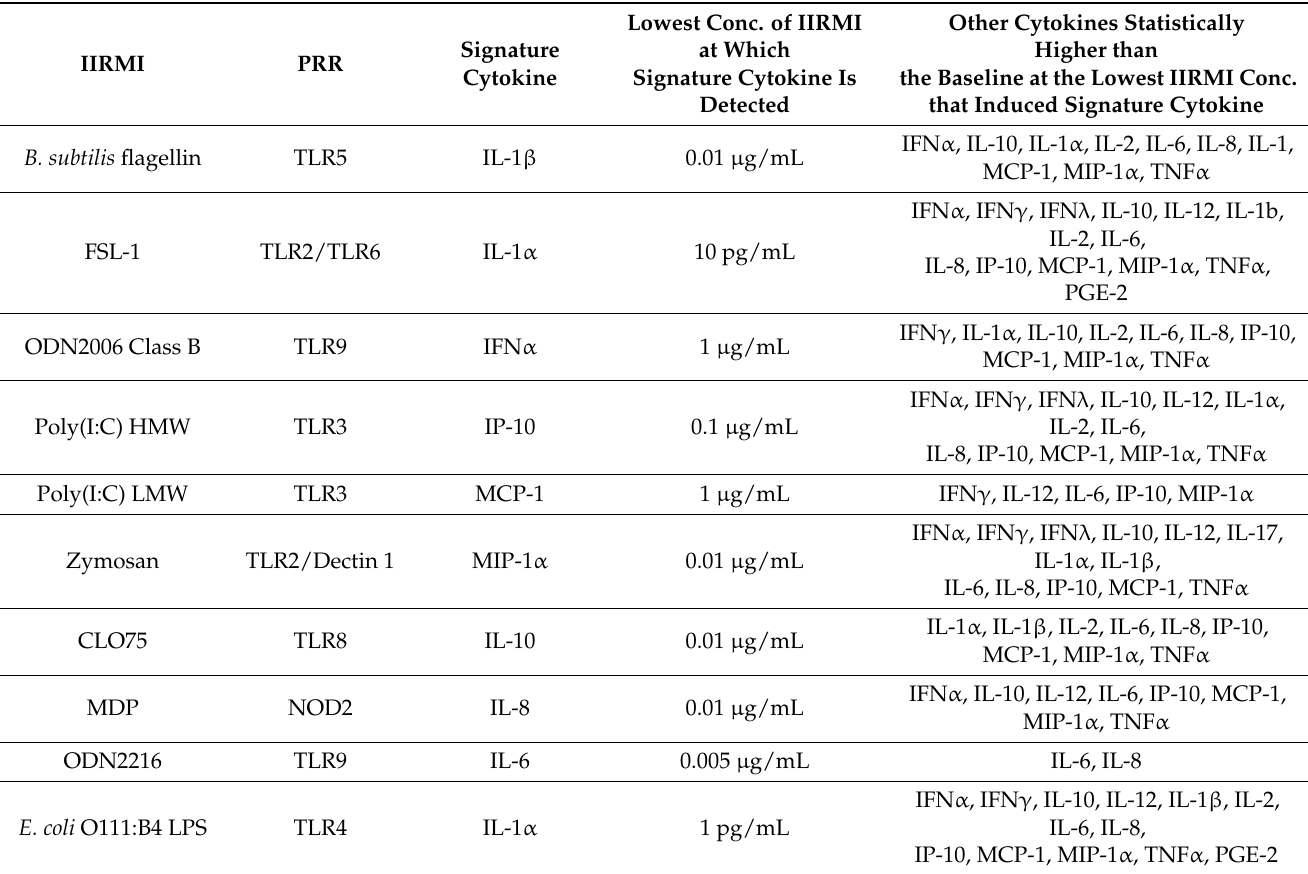
Table 2. Cytokines Induced by Innate Immune Response Modulating Impurities. Individual IIRMIs, their cognate pat- tern recognition receptors (PRRs), and signature cytokines detected after treatment with IIRMI are summarized. Using a two-sided Wilcoxon test, a signature cytokine was identified for each IIRMI by determining the lowest IIRMI con- centration, which, when compared to the baseline, resulted in an elevation of the cytokine, and had the lowest rank- ing p -value (i.e., at least p < 0.05). IIRMI = innate immune response modulating impurities; TLR = Toll-Like Receptor; IL = interleukin; IFN = interferon; MCP = monocyte chemoattractant protein; MIP = macrophage inflammatory protein; NOD = nucleotide-binding oligomerization domain; TNF = tumor necrosis factor; PGE = prostaglandin; LPS = lipopolysac- charide; CLO = thiazoloquinolone derivative; MDP = muramyldipeptide; ODN = oligo deoxyribonucleotide; LMW = low molecular weight; HMW = high molecular weight; FSL = Pam2CGDPKHPKSF, a synthetic lipopeptide derived from Mycoplasma salivarium